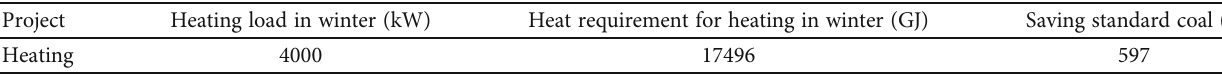
Table 9: Evaluation results of saving standard coal.